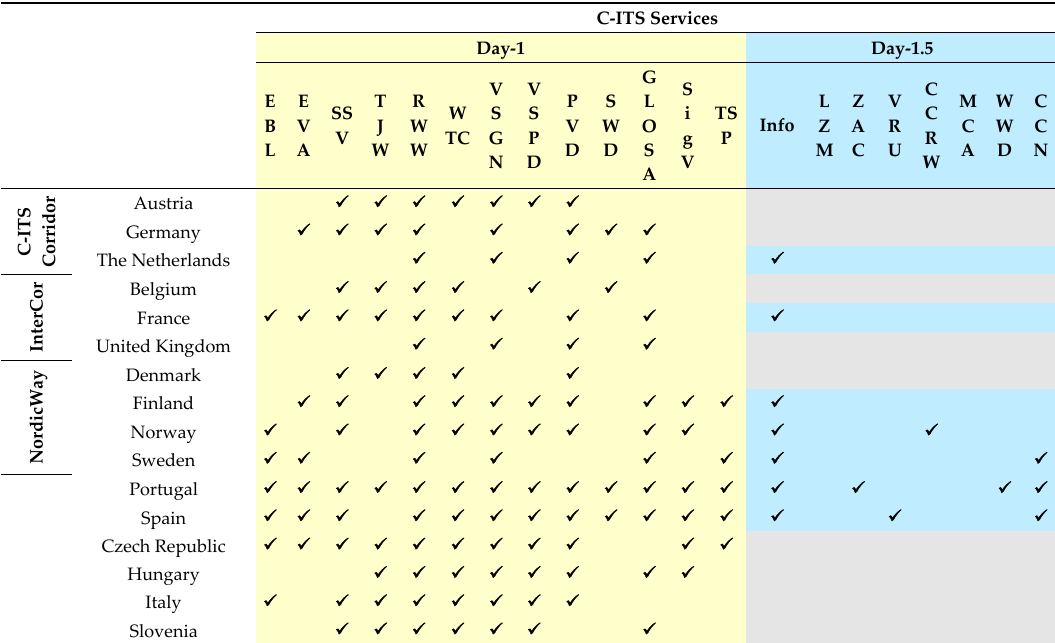
Table 2. C-ITS services tested in C-Roads pilot sites.